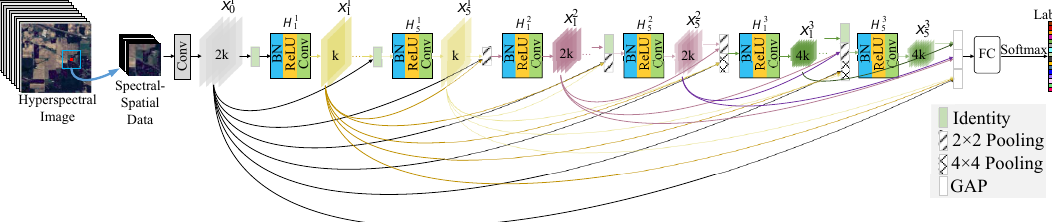
Figure 5. Framework of the proposed fully dense multiscale fusion network (FDMFN) for HSI classification. For convenience, the BN, ReLU layers that precede the global average pooling (GAP) layer are not given.